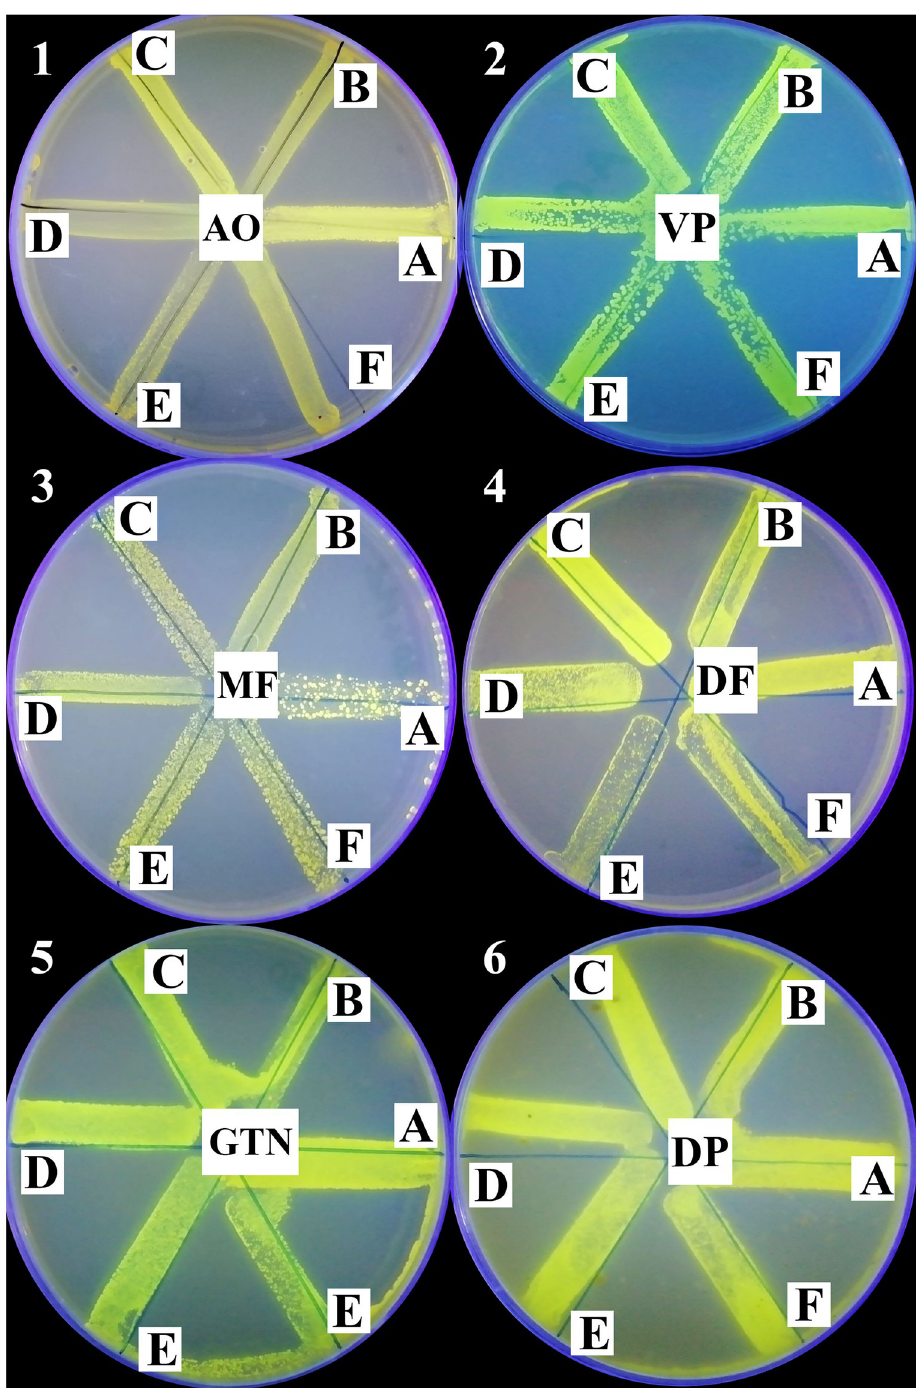
Fig 5. The efflux of 6 representative isolates (A; standard strain and B, C, D, E, and F; 5 tested isolates) in the absence of the tested compounds (acridine orange only; AO, negative control in sector 1) and in the presence of verapamil (VP; positive control in sector 2), metformin (MF in sector 3), diclofenac sodium (DF in sector 4), glyceryl trinitrate (GTN in sector 5) and domperidone (DP in sector 6) at the same AO concentration (10 mg/L).